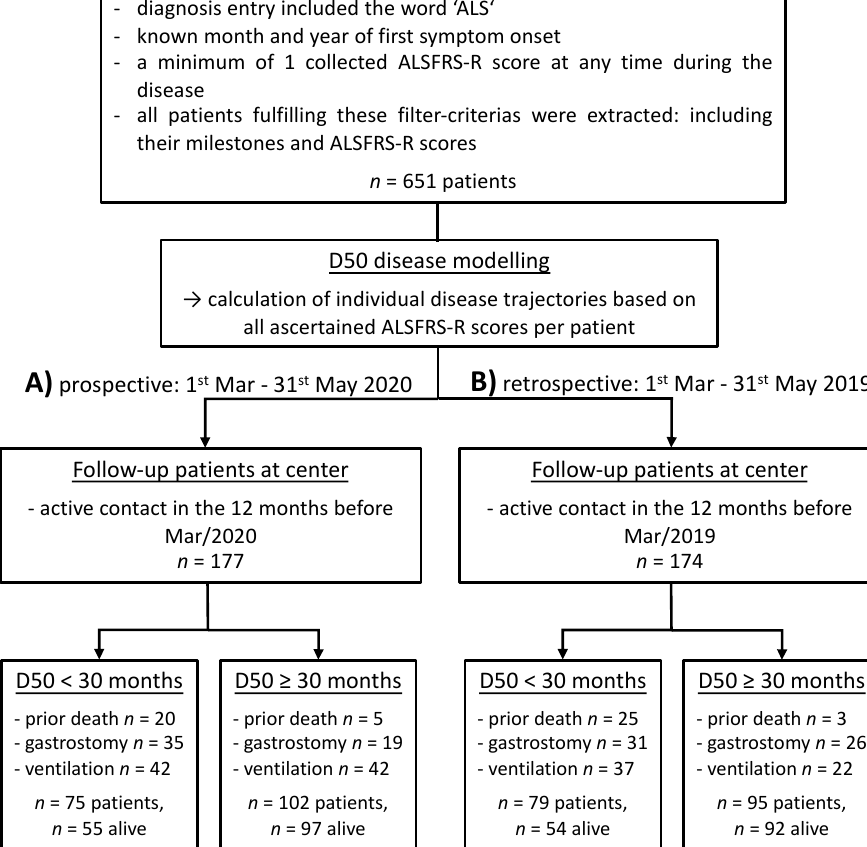
Figure 1. Consort diagrams for A) the prospective and B) the retrospective cohort under active follow-up. Patients were identified based on milestone-related entries in the neuromuscular database. Patients were then stratified based on their individual D50 values as either having high disease aggressiveness (D50 < 30 moths) or low aggressiveness (D50 ≥ 30 months). In the bottom-last row the numbers of events that occurred before the cut-o ff day (1 st March) are given for prior death, gastrostomy or initiation of assisted ventilation. Abbreviations: ALS = Amyotrophic Lateral Sclerosis; ALSFRS-R = ALS Functional Rating Scale (Revised); D50 = estimated time in months for an individual to lose 50% of functionality.